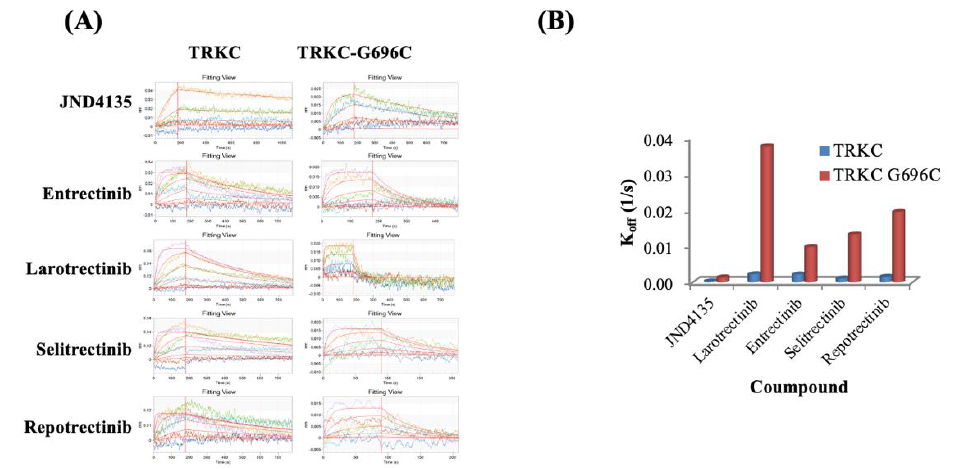
Figure 4. JND4135 occupies TRK protein for a long time. ( A ) Affinity activity of JND 4135 and reported TRKs inhibitors on TRKC and TRKC-G696C protein using BLI assays; ( B ) K off values of JND4135 and reported TRKs inhibitors on TRKC and TRKC-G696C.